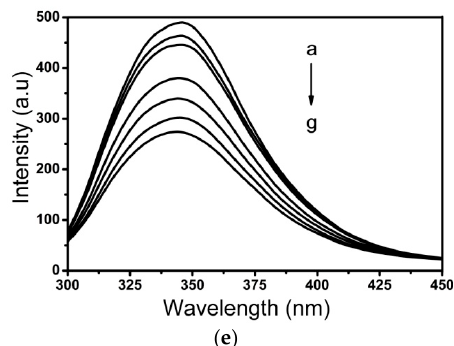
Figure 4. Fluorescence emission spectra of bovine serum albumin (BSA) with different concentrations of Cu 2+ -surfactin ( a ), Zn 2+ -surfactin ( b ), Mg 2+ -surfactin ( c ), Ca 2+ -surfactin ( d ) and surfactin ( e ). Conditions: BSA: 15 µM; metal-lipopeptide (a–g): 0, 10, 20, 50, 70, 100 and 120 µM; pH = 7.4; T =25 °C.